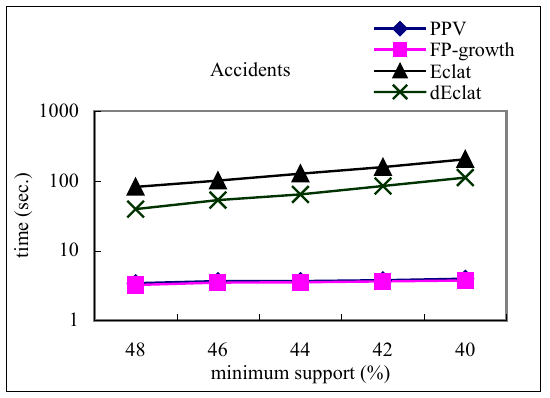
Fig. 7. Comparative Performance on T40I30D1000K